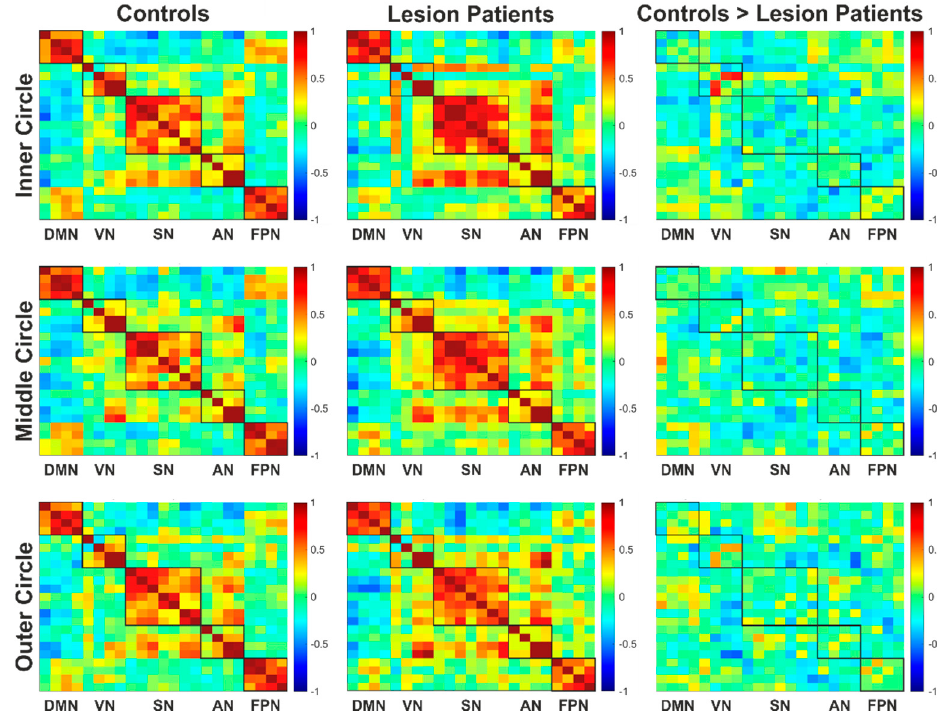
Figure 10. Connectivity matrices of the control group and lesion patients group (each N = 7) and the resulting difference of the controls > lesion patients. The boxes mark the examined networks and the intra-network connectivity they contain. Connections that were more pronounced in the control group are shown in yellow/red, depending on their strength, while those that were more pronounced in the lesion patients are shown in light/dark blue. If there were no differences, this is shown in green. Abbreviations: AN: attention network, DMN: default mode network, FPN: frontoparietal network, SN: salience network and VN: visual network.